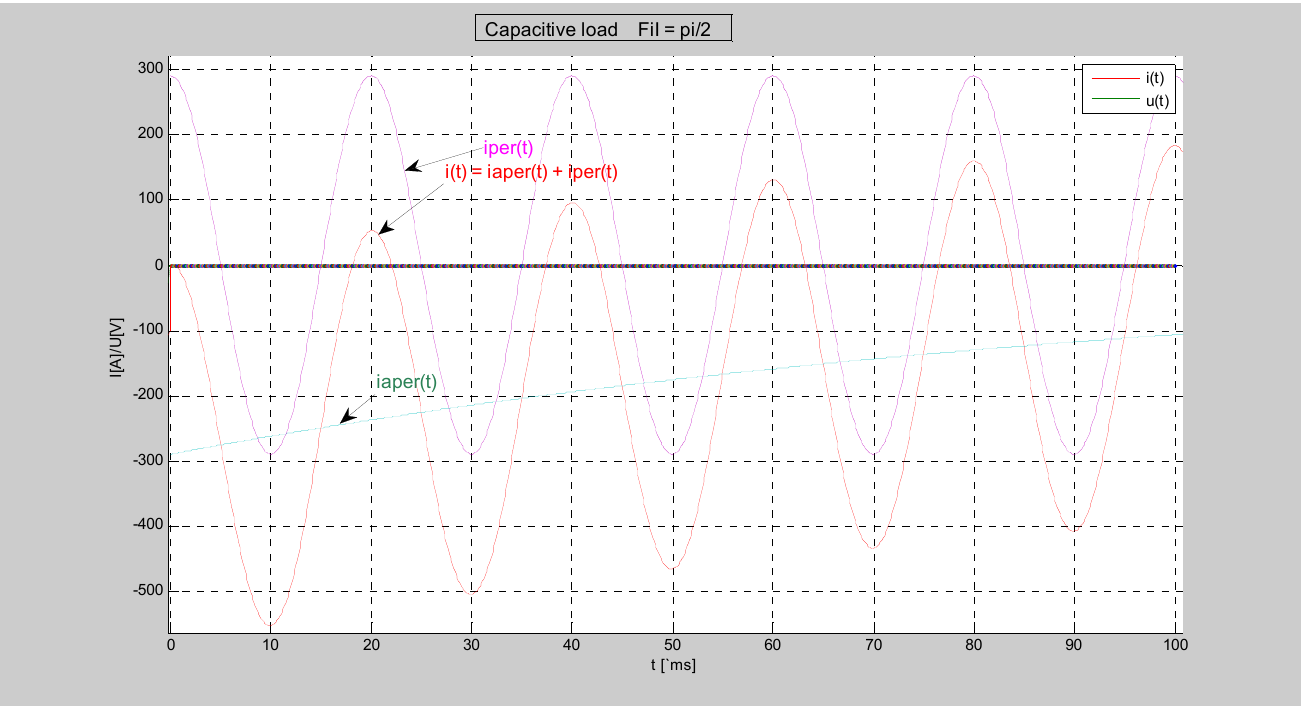
Figure 9. Components of the transient characteristic on capacitive load; over time, t ∈ (0,100) ms.